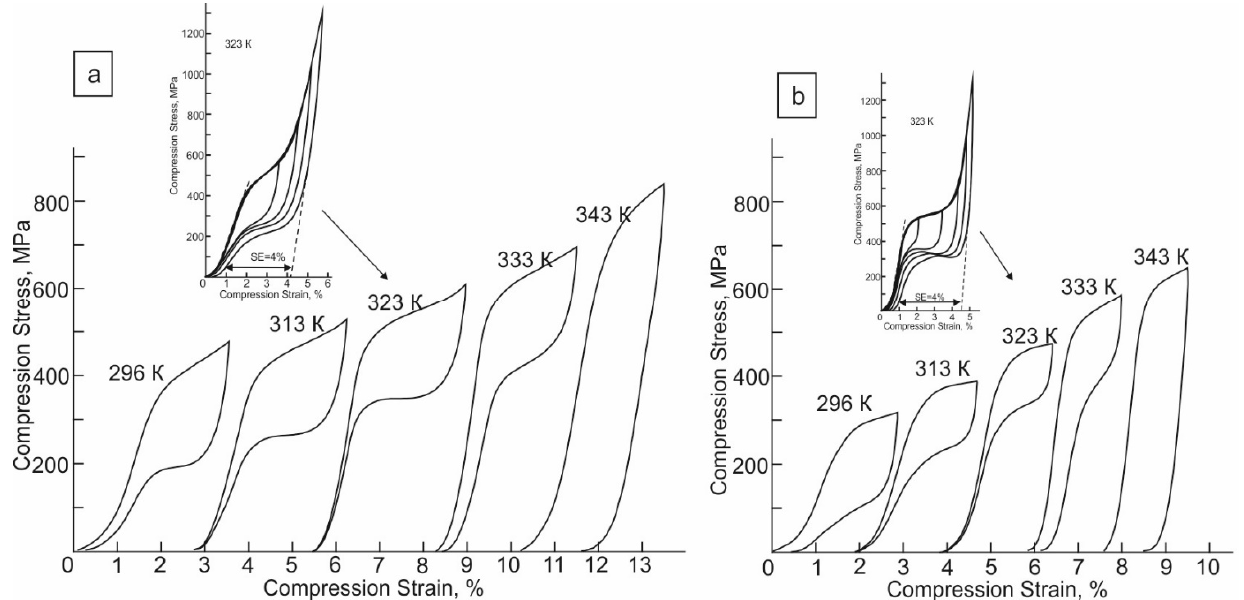
Figure 5. Temperature range of superelastisity in the compressive-tested [011]-oriented Ti-50.1Ni single crystals: ( a )—after annealing at 713 K for 0.5 h in helium gas; ( b )—after annealing at 713 K for 0.5 h in dry air.